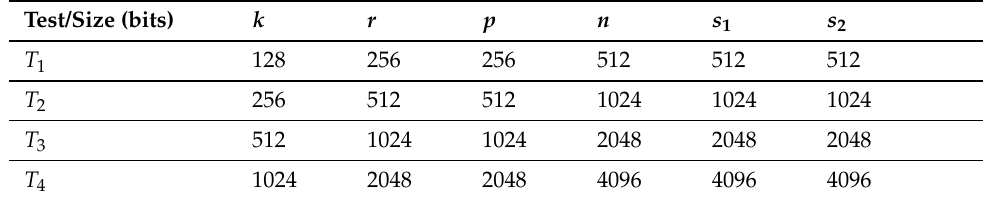
Table 2. Parameter sizes in the different tests.